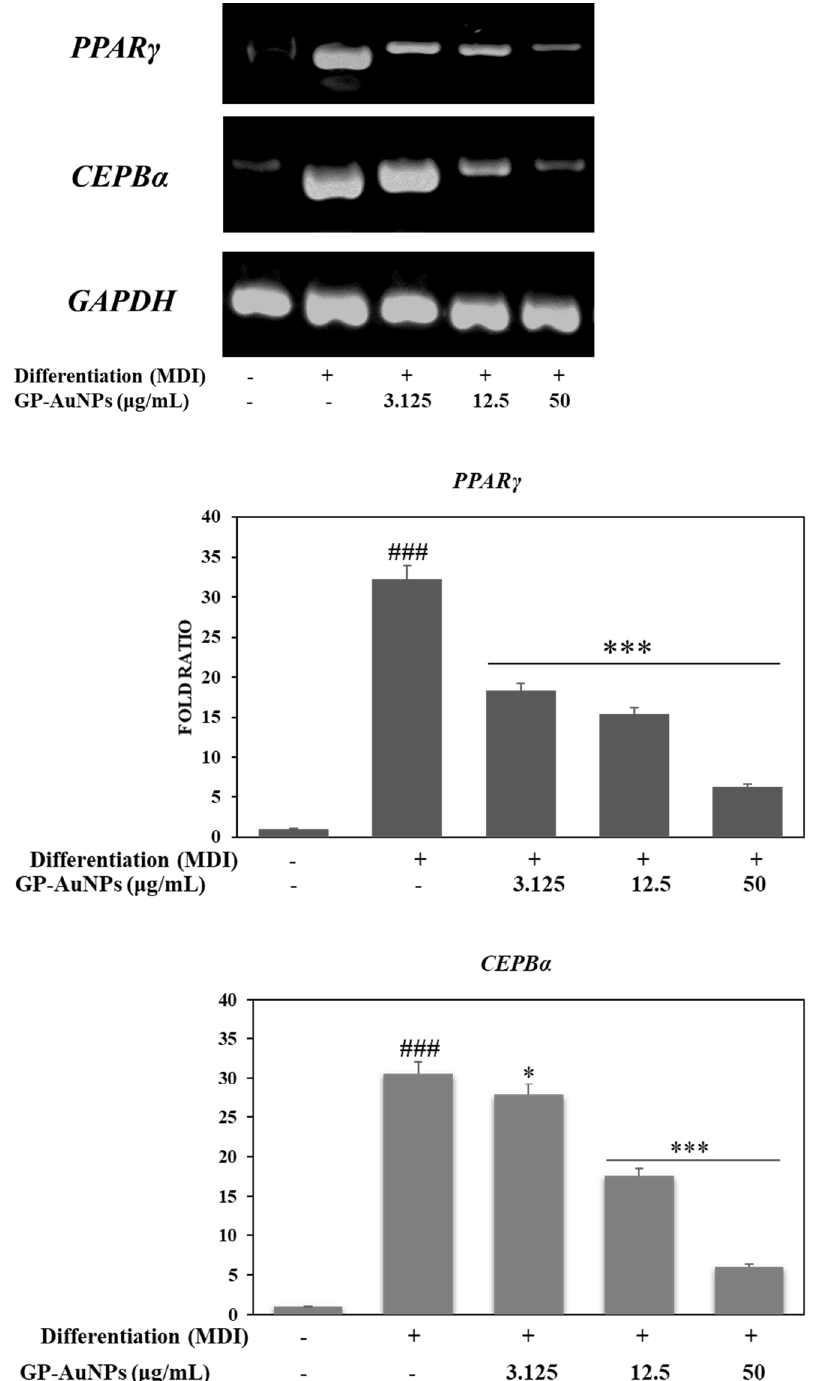
Figure 12. Effects of GP-AuNPs on mRNA expression levels of adipogenesis-related genes in 3T3-L1 cells. GP-AuNPs inhibit the RNA level of adipogenesis-related genes. ### <0.01 compared with control, * p < 0.05, *** p < 0.001 compared with the MDI.